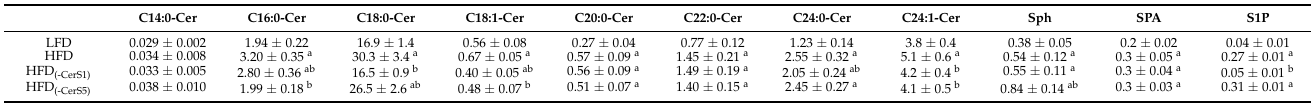
Table 4. Impact of CerS1 and CerS5 gene silencing on the content of individual sphingolipids in mouse gastrocnemius muscle of HFD-fed animals. Values are mean pmol/mg of tissue ± SD; n =